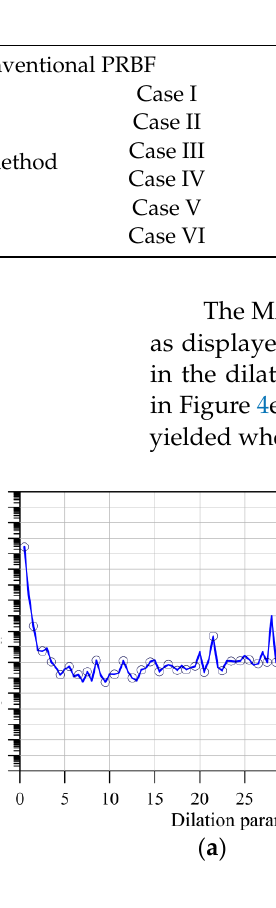
( f ) Figure 4. The computed MAE versus the dilation parameter )1( = k